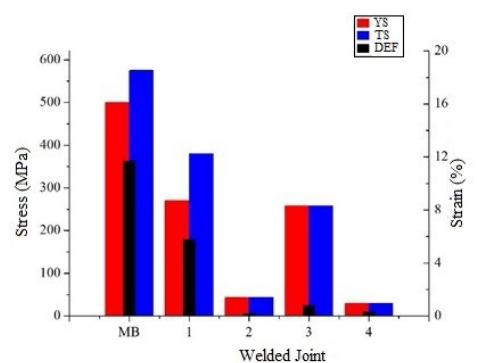
Figure 12. Main values obtained in the uniaxial traction